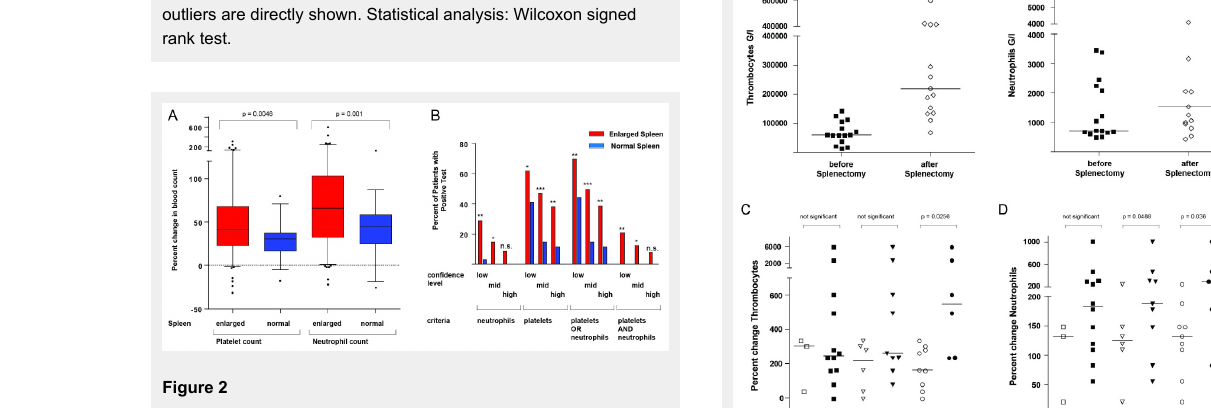
A: Changes in platelet and neutrophil counts in patients according to spleen pole diameter. Statistical analysis: Mann Whitney U test; box plot and whiskers as described in the legend for figure 1. B: Higher frequency of positive tests in patients with an enlarged spleen compared to patients with a normal size spleen. Different criteria for the evaluation of EST were defined requiring either neutrophils, platelets, one of each (“platelets OR neutrophils”) or both (“platelets AND neutrophils”) to be above the respective cutoff. Limits of low, intermediate ("mid") and high confidence of the test were defined: For platelets an increase of 30%, 40% or 50% respectively was chosen. For neutrophil counts these values were 60%, 100% or 150% respectively. Significance was calculated using Fisher’s exact test.